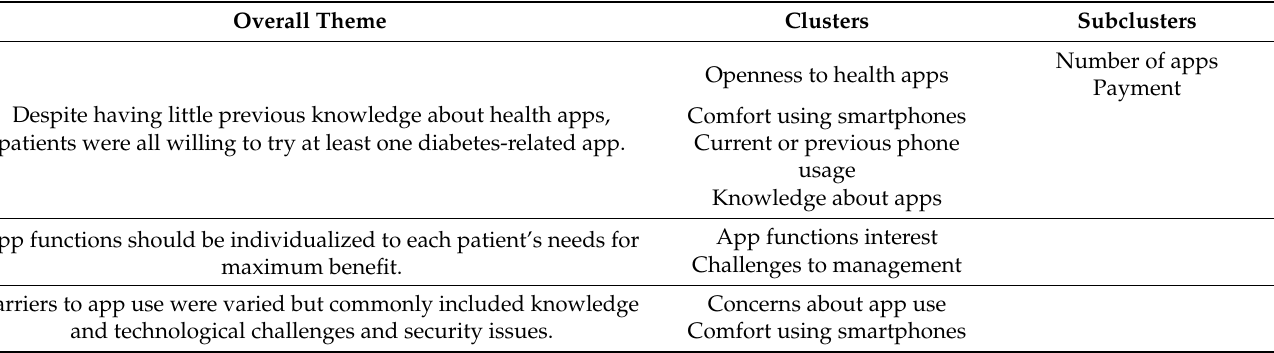
Table 2. Summary of overall mHealth themes derived from all personal interviews with their supporting clusters. Overall Theme Clusters Subclusters Despite having little previous knowledge about health apps, patients were all willing to try at least one diabetes-related app.